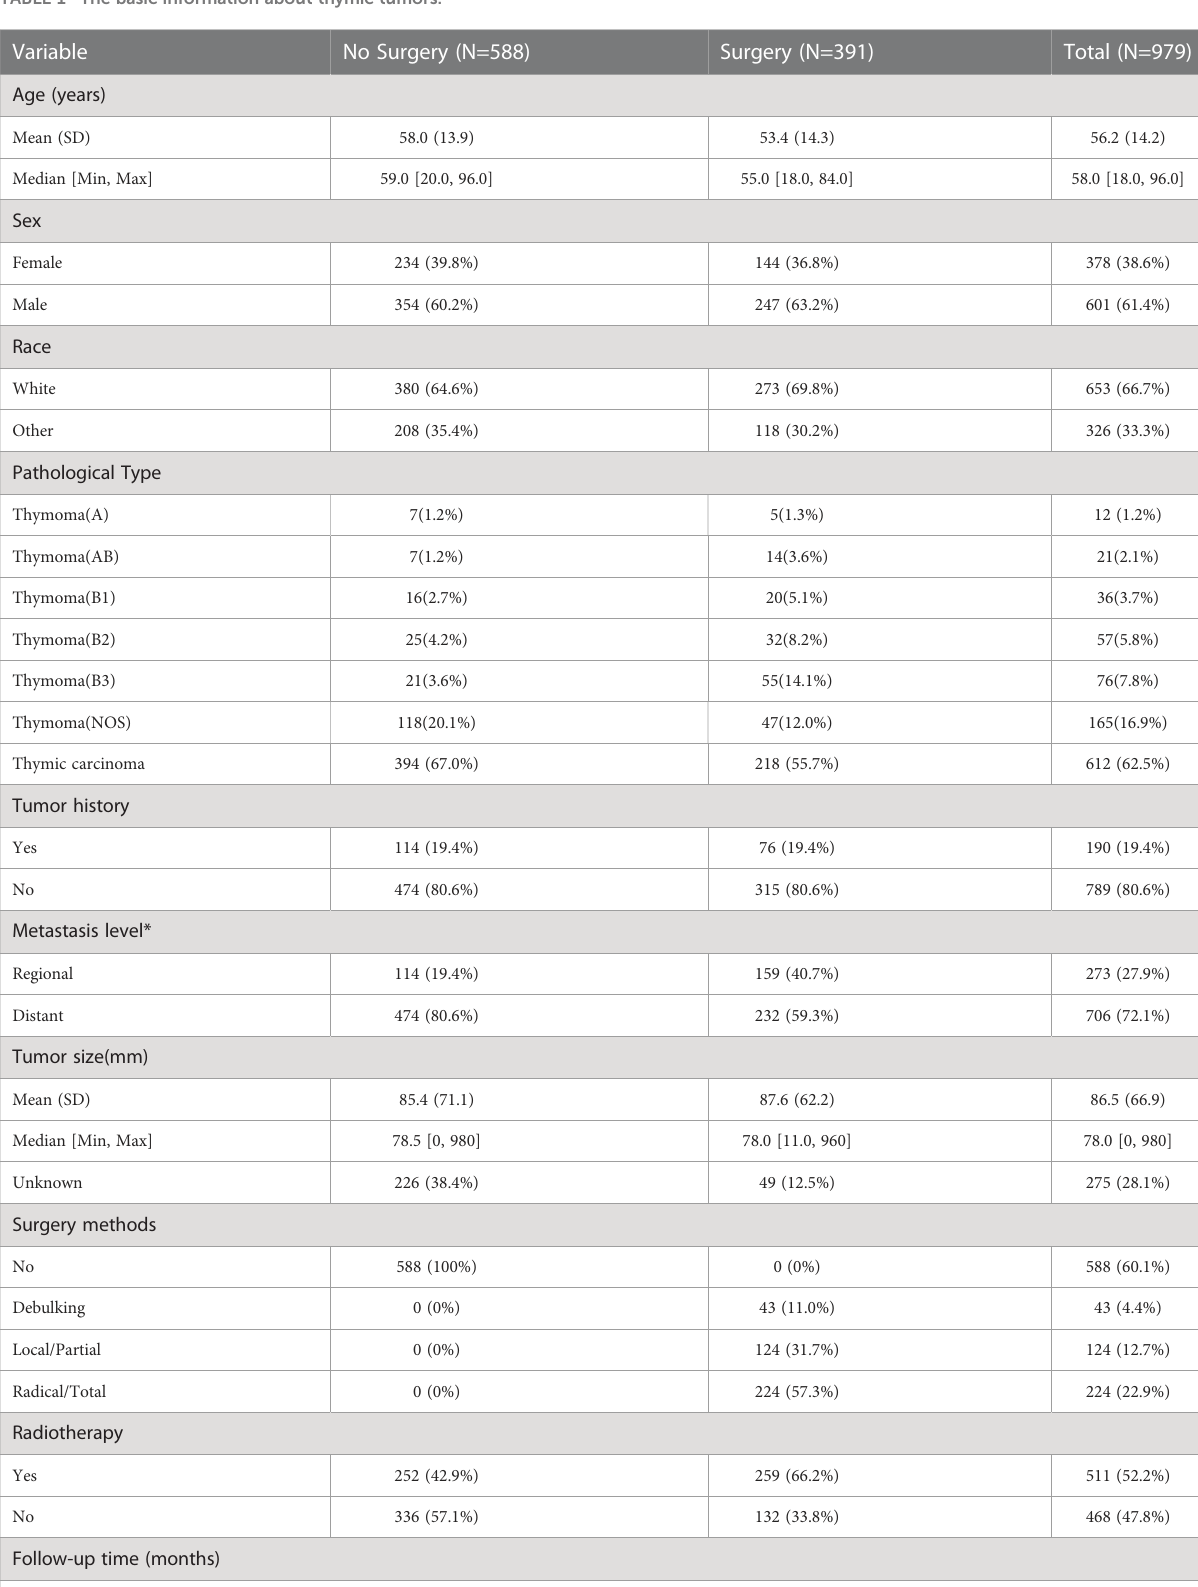
TABLE 1 The basic information about thymic